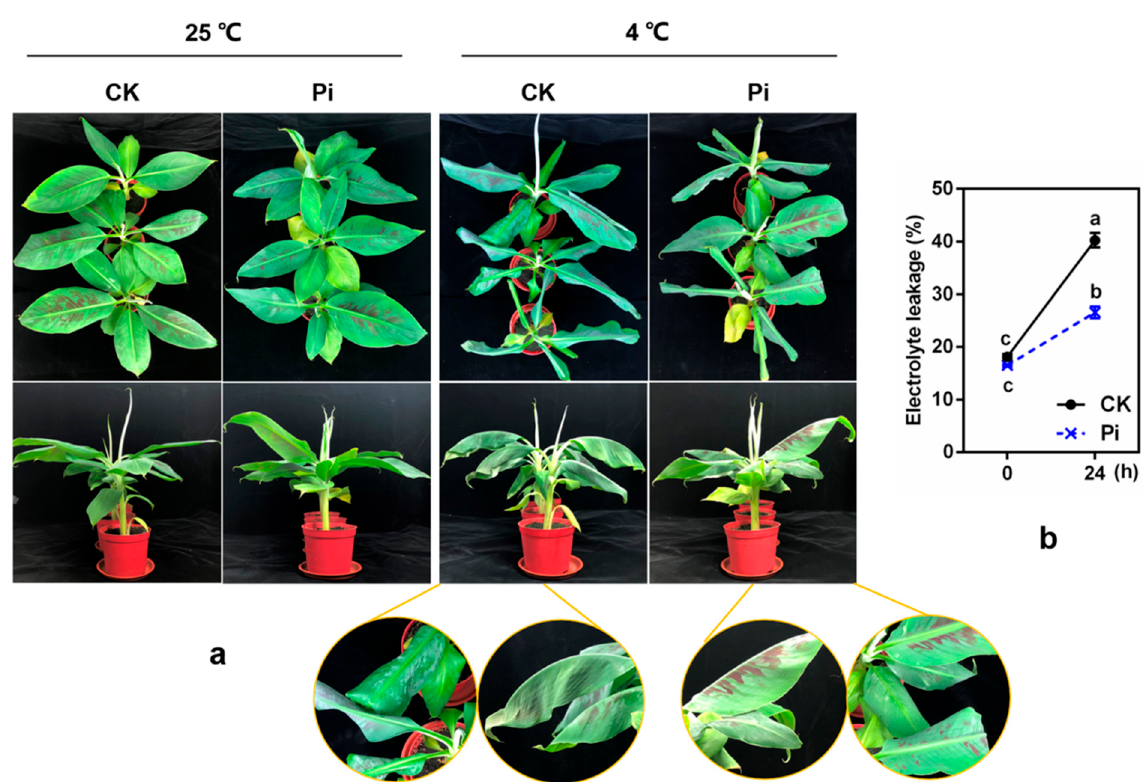
Figure 2. Effect of P. indica on the phenotypes ( a ) and relative electrolyte leakage ( b ) of banana before and after 4 °C cold treatment for 24 h. CK: P. indica non-colonized control plants; Pi: plants inoculated with P. indica . Different letters above the bars indicate a significant difference ( p < 0.05) from CK (0 h) between CK and Pi groups. Error bars represent SDs ( n = 3).